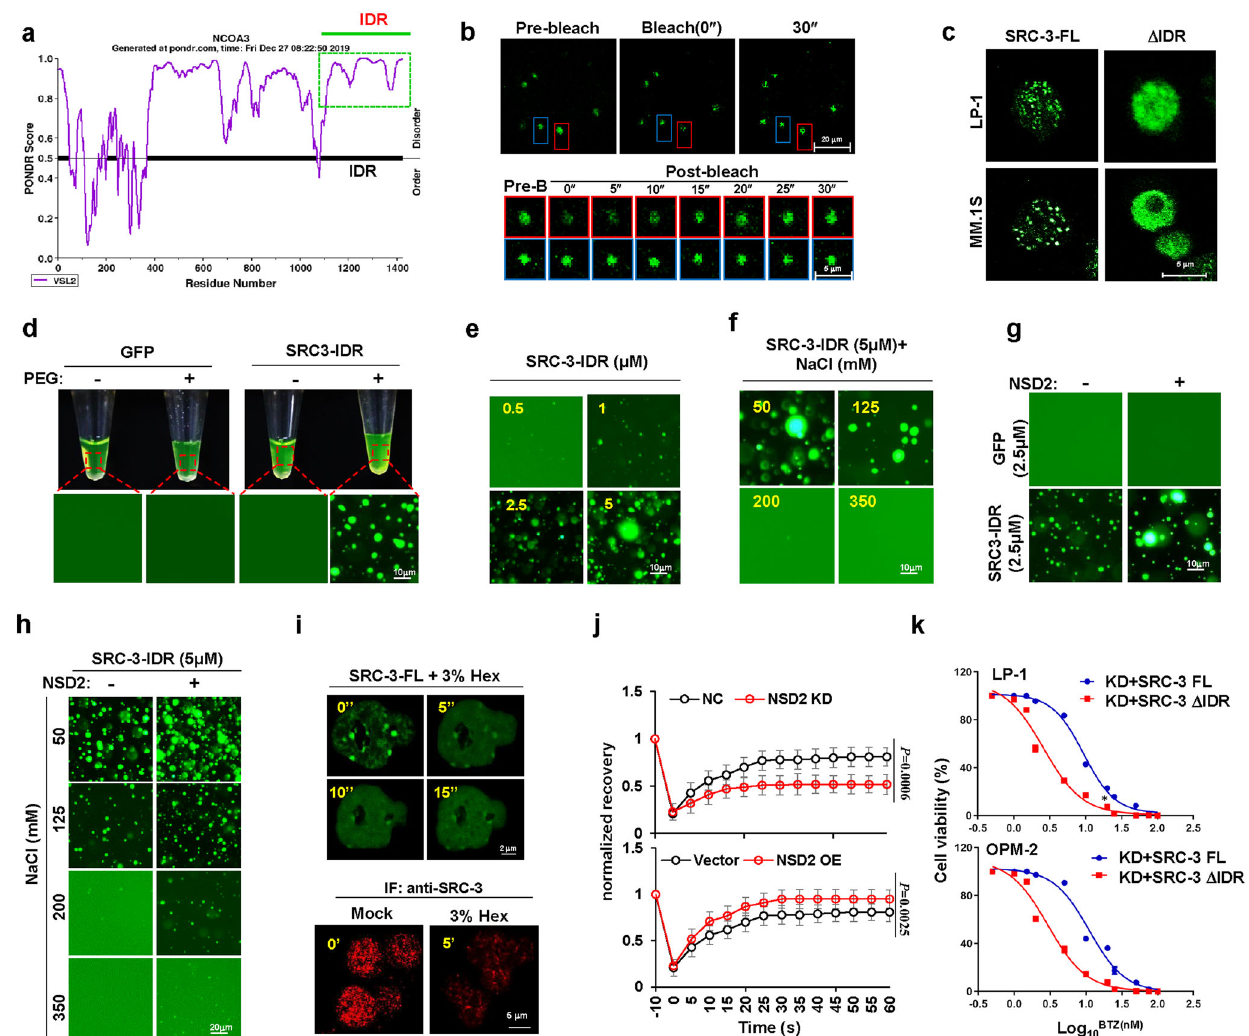
Fig. 5 NSD2 enhances SRC-3 liquid – liquid phase separation in BRZ-resistant myeloma cells. a Prediction of intrinsically disordered regions (IDRs) (green frame) of SRC-3 protein using a PONDR algorithms. b Fluorescence recovery after photobleaching (FRAP) of a SRC-3-GFP focus (red framed) by 488 nm laser for 5 ″ bleaching and 30 ″ recovery in MM.1S cells, and the blue framed focus was used as a control ( n = 3 biologically independent experiments). c Phase separation formation of full-length GFP-SRC-3 (FL) and IDR domain depletion GFP-SRC-3 ( Δ IDR) in MM.1S and LP-1 cells (n = 3 biologically independent experiments). Scale bar, 5 μ m. d Visualization of turbidity associated with droplet formation. Tubes containing SRC-3-IDR (right pair) or GFP (left pair) in the presence ( + ) or absence ( − ) of PEG-8000 ( n = 3 biologically independent experiments). e Representative images ( n = 3 biologically independent experiments) of droplet formation of GFP-SRC-3-IDR at different protein concentrations. f Representative images ( n = 3 biologically independent experiments) of GFP-SRC-3-IDR at 5 μ M protein concentration droplet formation at different salt concentrations. g Representative images ( n = 3 biologically independent experiments) of droplet formation of GFP-vector or GFP-SRC-3-IDR in the presence ( + ) or absence ( − ) of NSD2. h Representative images ( n = 3 biologically independent experiments) of droplet formation of GFP-vector or GFP-SRC-3-IDR in the presence ( + ) or absence ( − ) of NSD2 at different salt concentrations. GFP-vector or GFP-SRC-3-IDR was added to droplet formation buffer to achieve 5 μ M protein concentration with a fi nal NaCl concentration as indicated. i Phase separation formation of full-length GFP-SRC-3 (FL) in HEK293T cells before and after treatment with 3% 1,6-hexanediol at different times (upper). Representative micrographs ( n = 3 biologically independent experiments) of confocal immuno fl uorescence for endogenous SRC3 droplet foci in MM.1S cells before and after treatment with 3% 1,6-hexanediol for 5 s (lower). j Kinetic recovery times of bleached GFP-tagged SRC-3 droplet foci in HEK293T co-transfected with NSD2 shRNA (NSD2 KD) or expressing vector (NSD2 OE) by 488 nm laser ( n = 3 biologically independent experiments). Two-sided P -values of the comparisons between the fi nal extent of recovery after photobleaching (i.e. 60 s)were performed using one-way ANOVA; mean ± s.d. k Alteration of IC 50 to bortezomib (BTZ) treatment in LP-1 and OPM-2 SRC-3 knockdown (KD) cell lines in the presence of SRC-3 full length (SRC-3 FL) or IDR region depletion truncation (SRC-3 Δ IDR) ( n = 3 biologically independent experiments). Source data are provided as a Source Data fi